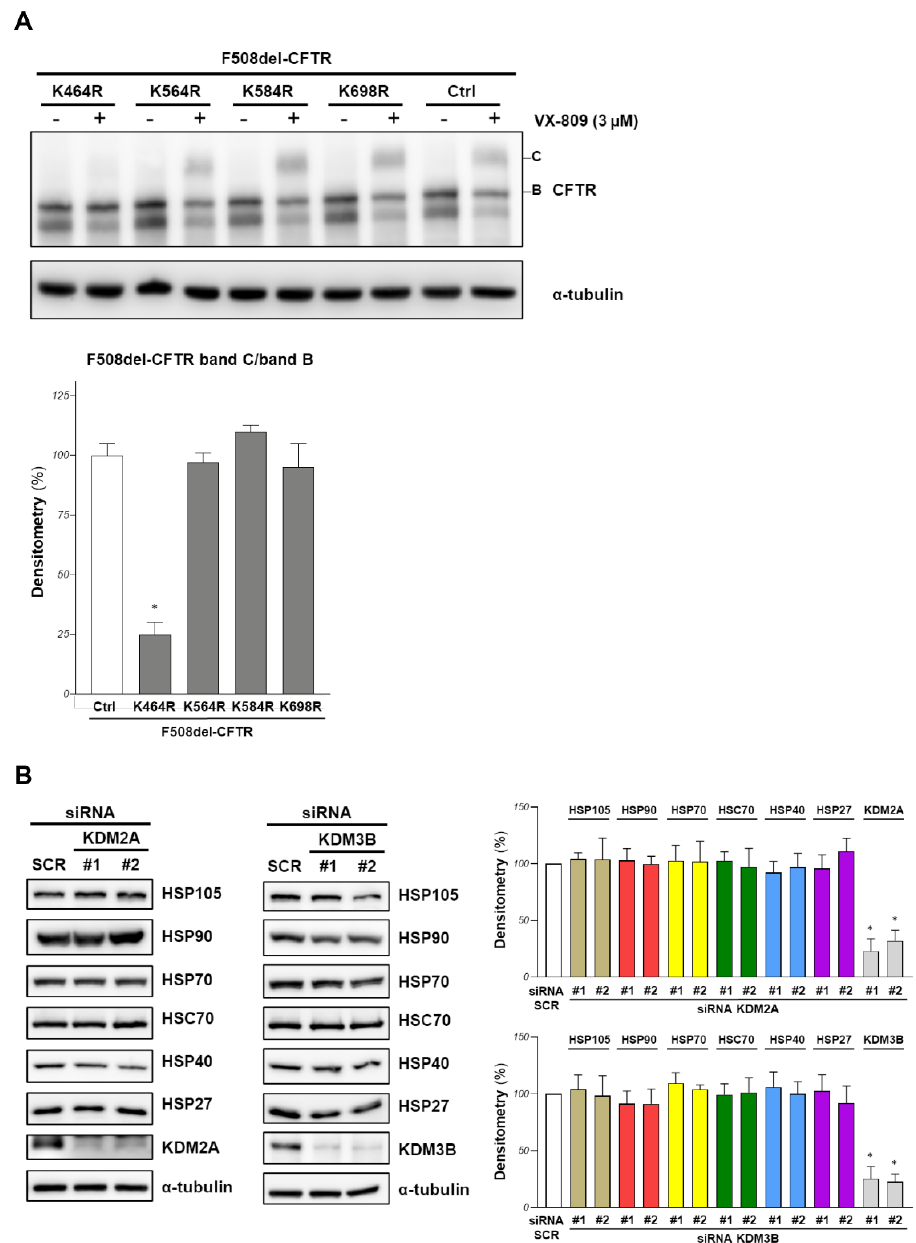
Figure 4. Mutational analysis of CFTR methylated lysine and effect of demethylases downregulation on chaperone machinery. ( A ) CFBE41o- cells were transiently transfected with F508del-CFTR, or other derivative mutants as indicated. After 24 h, cells were treated with 3 μM VX -809 and the amounts of F508del- CFTR band B and band C were assessed by western blotting. α -tubulin was used as loading control (upper panel). In the lower panel, the graphs show the ratio of F508del- CFTR band C/band B for the cells treated with VX-809, obtained by the densitometric quantification of the immunostained band C normalized by band B expression, and expressed as a percentage of the control cells (Ctrl) (means ± SD values, n = 4; * p < 0.05 vs. Ctrl). ( B ) F508del-CFTR expressing CFBE41o- cells were transfected with siRNA (#1 and #2 guides) targeting KDM2A or KDM3B or with a scrambled (SCR) siRNA for 48 h. In the left and central panels, the expression of the indicated chaperones was analysed by western blotting. α -tubulin was used as loading control. In the right panel, the graphs report the densitometric quantification of the immunostained bands of the experiment detailed in the left and central panels normalized by α -tubulin expression, and expressed as a percentage of the control cells (SCR). (Means ± SD values, n = 3; * p < 0.05 vs. SCR).